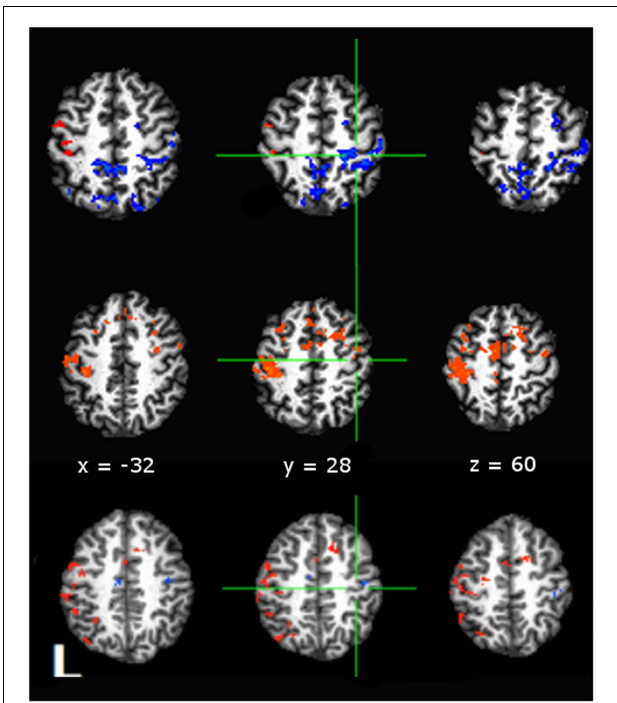
FIGURE 3 | Comparisons of area-under-curve (AUC) of the deconvolved hemodynamic response during performance of a tapping task taken against a null baseline condition with significance set to p < 0.05, False Discovery Rate corrected (Hues: orange indicates positive t -statistic, blue indicates negative t -statistic) . Data shown for: top row, active middle age adults; middle row, sedentary middle age adults; bottom row, younger adults. Both middle age adults and young adults showed a negative to baseline pattern of activity in rM1, while sedentary middle age adults showed positive to baseline activity in rM1. Anatomical underlay is a skull-stripped standardized (MNI152)T1 image.